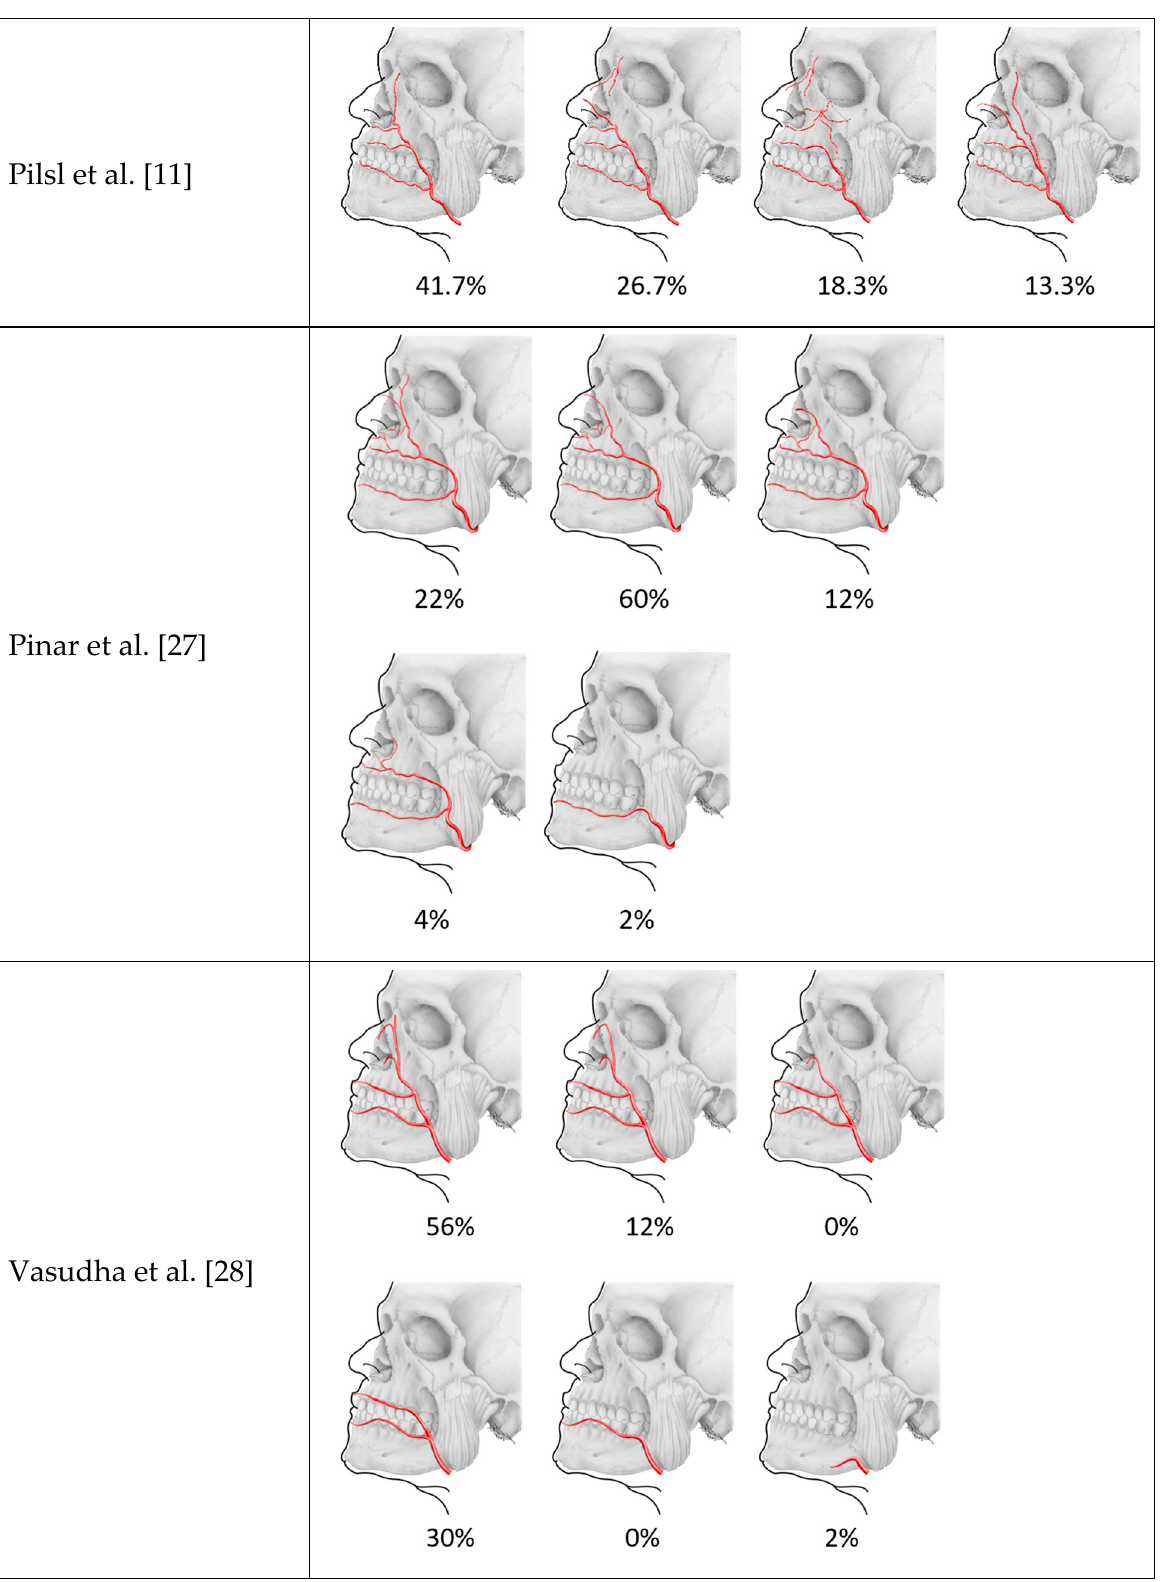
Figure 2. Types of facial artery according to prior literature. Lateral views according to the original depiction.